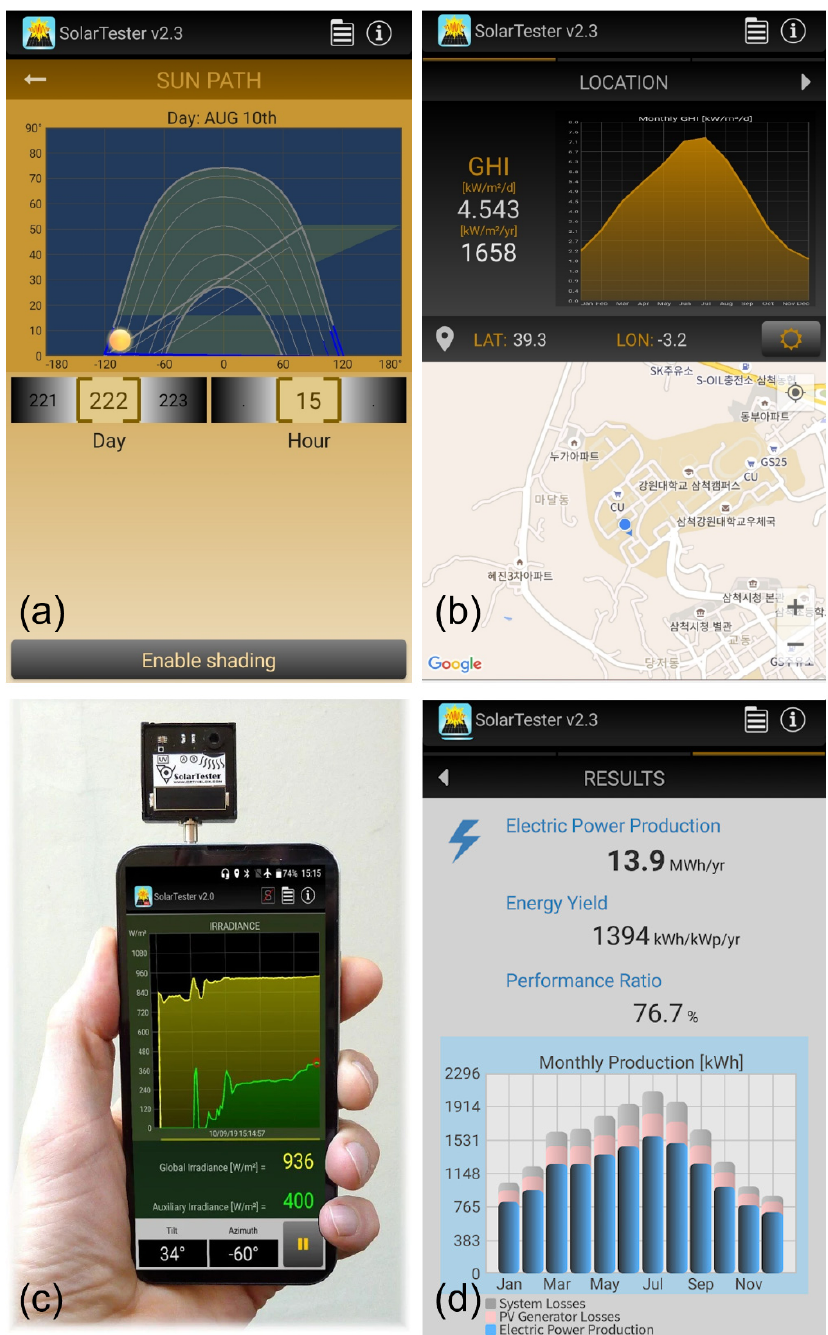
Figure 4. Representative smartphone applications, SolarTester Pro, for ( a ) PV potential assessment, ( b ) analysis of solar irradiation DB, ( c ) solar irradiation measurement [73], and ( d ) final results.